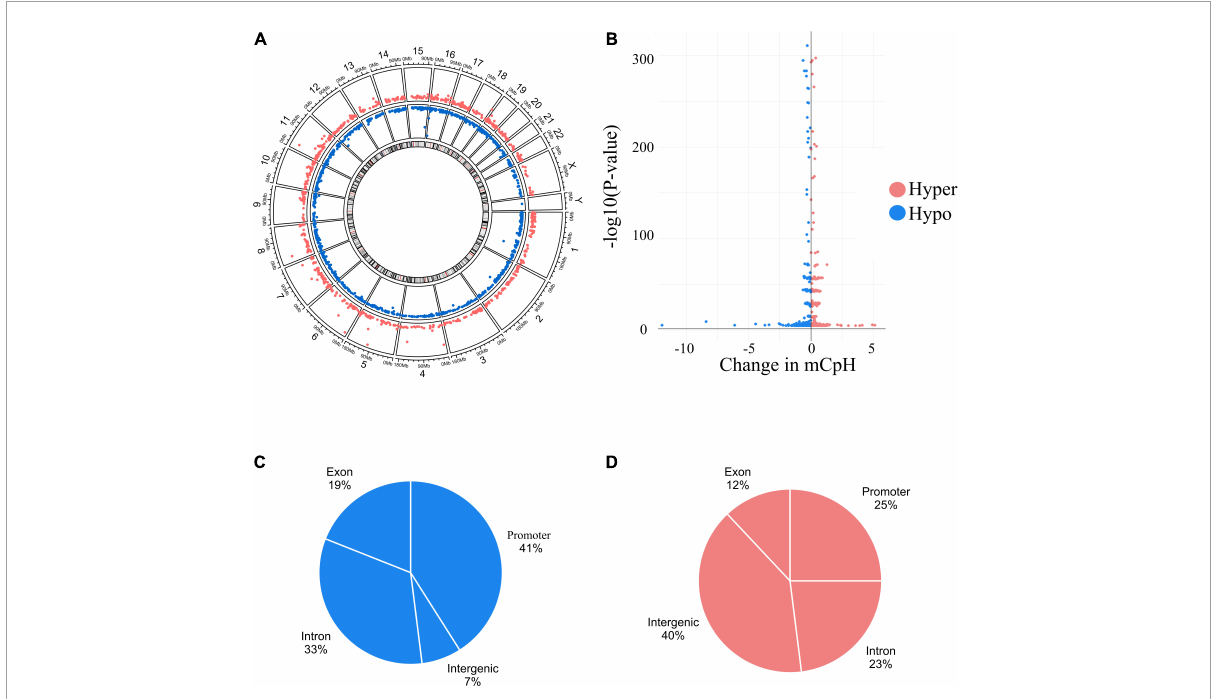
FIGURE2 Differential mCpHs sites associated with OUD. (A) Circus plot showing hypermethylated and hypomethylated sites. (B) Volcano plot of the differential sites. (C) Genomic location of hypermethylated and (D) hypomethylated differential